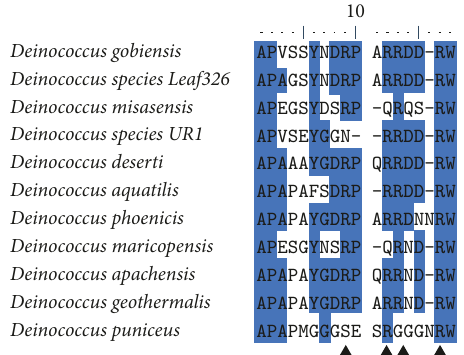
Figure 5: Multiple sequence alignment of C-terminal region of Dm-Csp1 and related, representative Deinococci-encoded cold shock proteins . Species names are indicated, regions of 50% or greater conservation are marked blue, and the positions of arginine-rich areas are denoted by arrowheads.